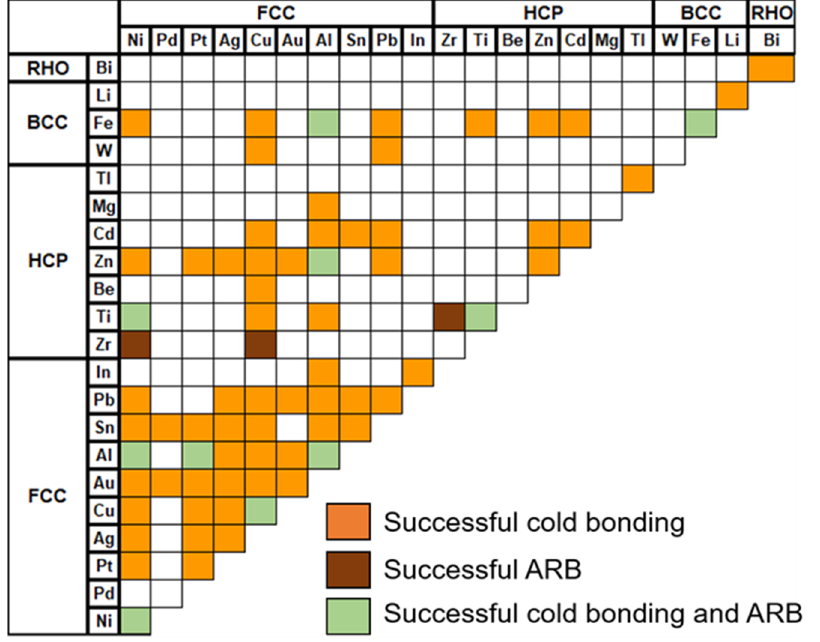
Figure 14. Compatibility mapping for cold roll bonding and ARB. Adapted from Ref. [11].